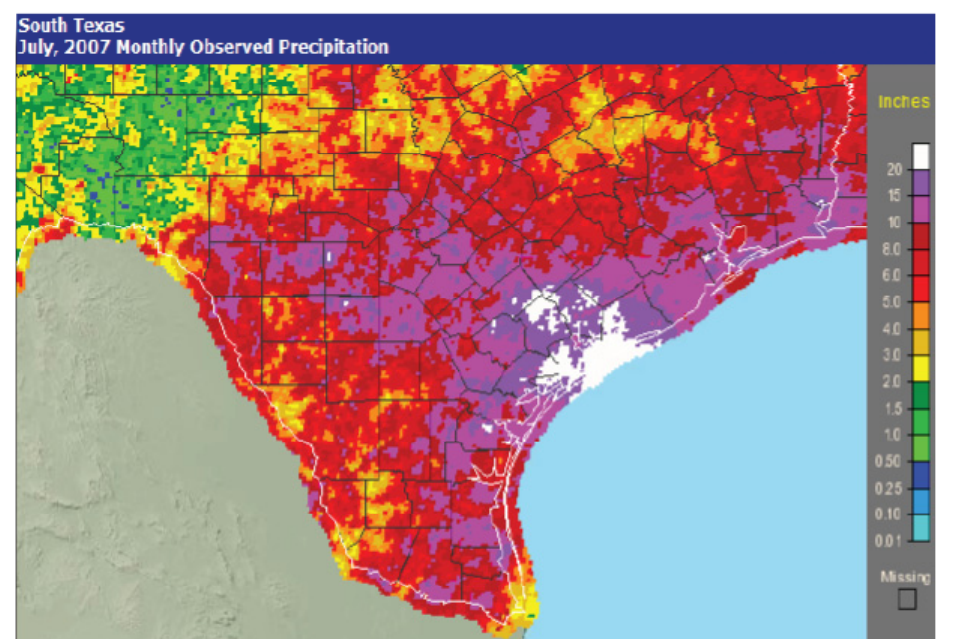
Figure 2. July 2007 observed precipitation